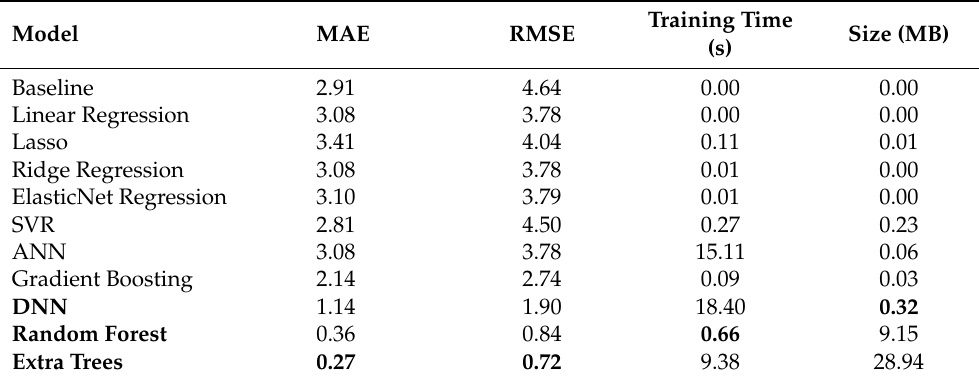
Table 4. Comparison of the machine learning techniques for FEAT2.